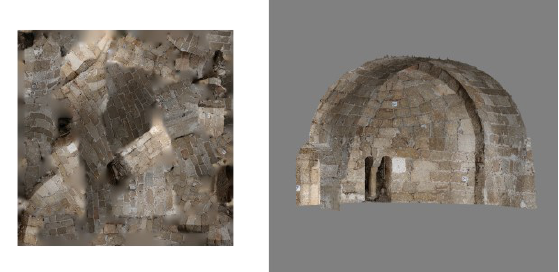
Figure 5. The image of the texture and the textured model of part of the altar.